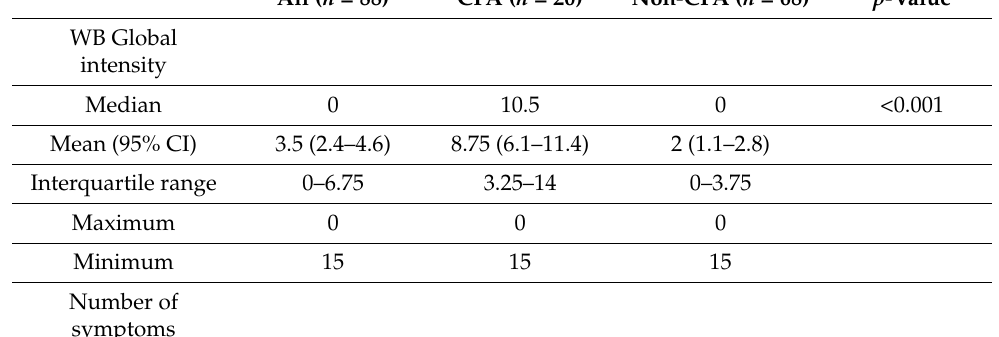
Table 3. Western blot global intensity and number of symptoms in CPA and non-CPA groups.